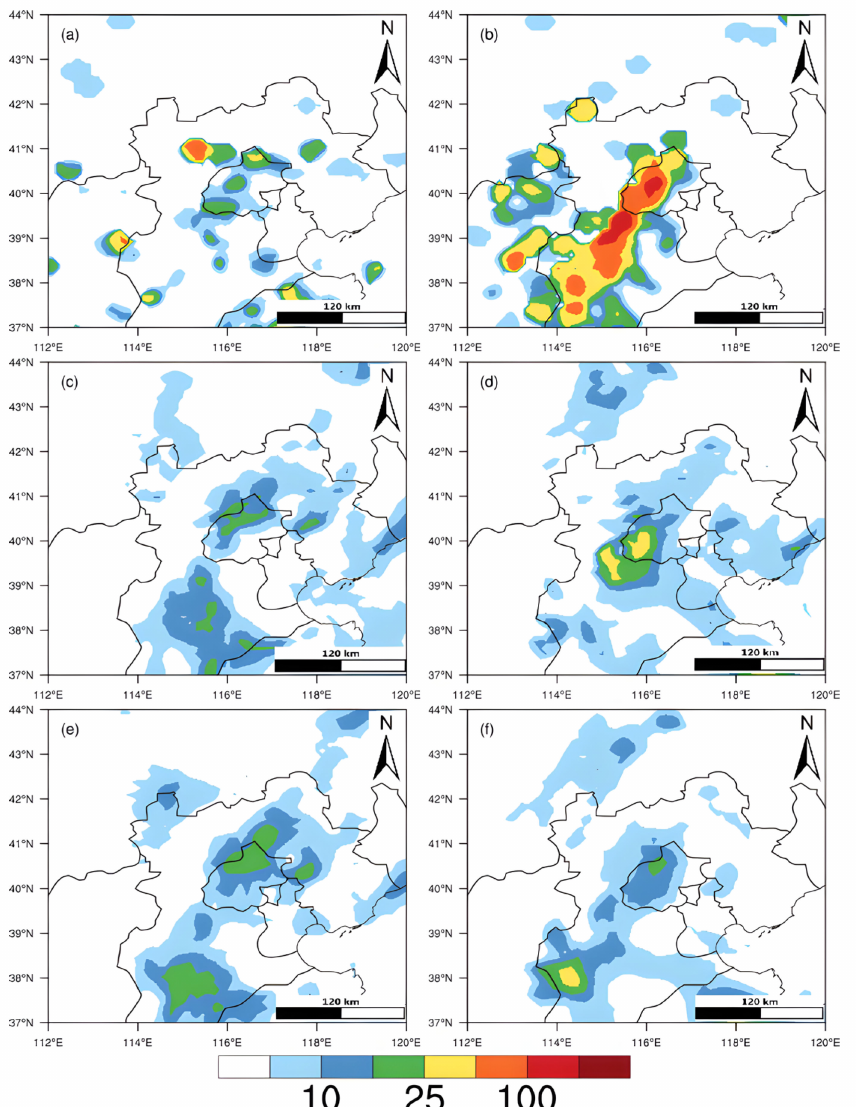
Figure 13. The 24 h cumulative rainfall (unit: mm) on 16 and 17 July 2021 with the model start time of 00:00 on the 15th: ( a , c , e ) are the rainfall on 16 July, ( b , d , f ) are the rainfall on 17 July. ( a , b ) Measured rainfall, ( c , d ) rainfall simulated using the new orography, ( e , f ) rainfall simulated using the model’s original